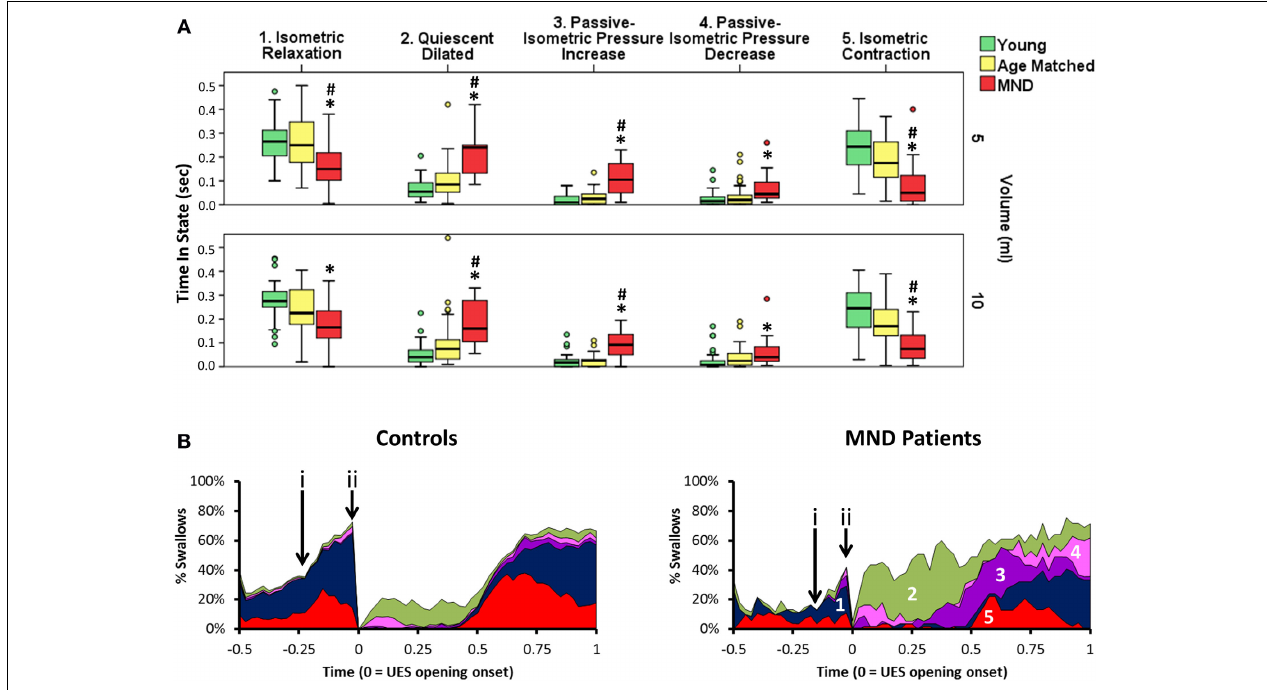
FIGURE 12 | Predicted UES mechanical states in Controls and Patients with MND. (A) Group differences in relation to the duration of five UES mechanical states that differentiated MND patients from Control Subjects. ∗ # indicates significant One-Way ANOVA and pairwise significance vs. Young Controls ∗ or Age Matched Controls# using Multiple Comparison Procedures.